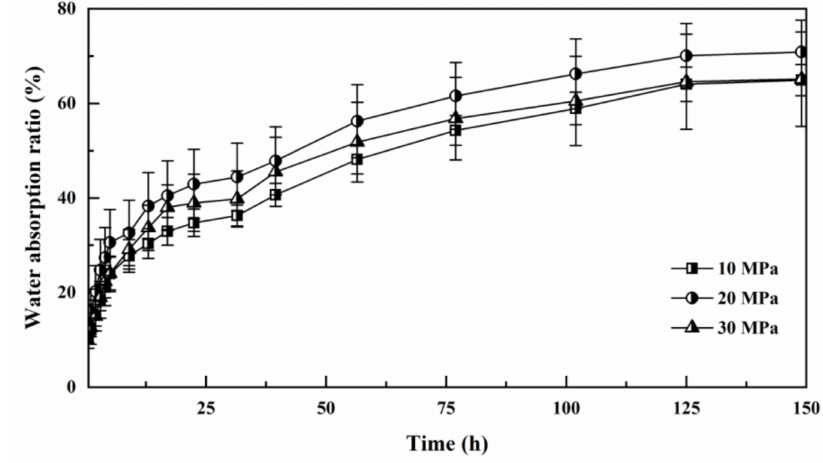
Figure 9. Water absorption ratio of wood after 1 h of SCD at di ff erent